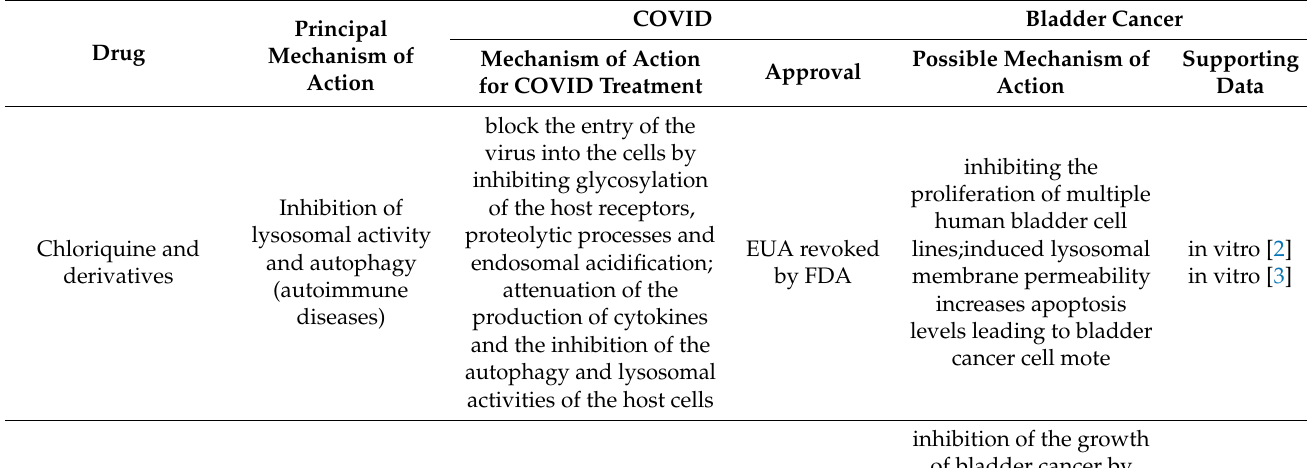
Table 1. Treatments for COVID-19 infection used in repurposing/repositioning modalities with applicability in the BCa